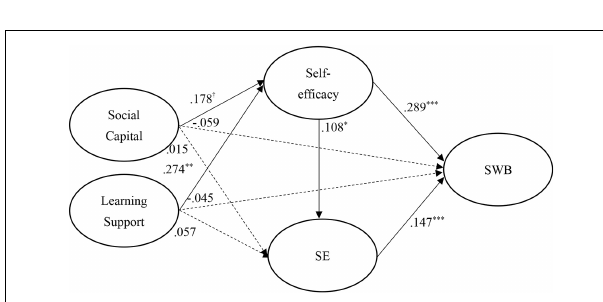
FIGURE 4 | Structural model on mainland China students. † p < 0.1; * p < 0.05; ** p < 0.01; *** p <